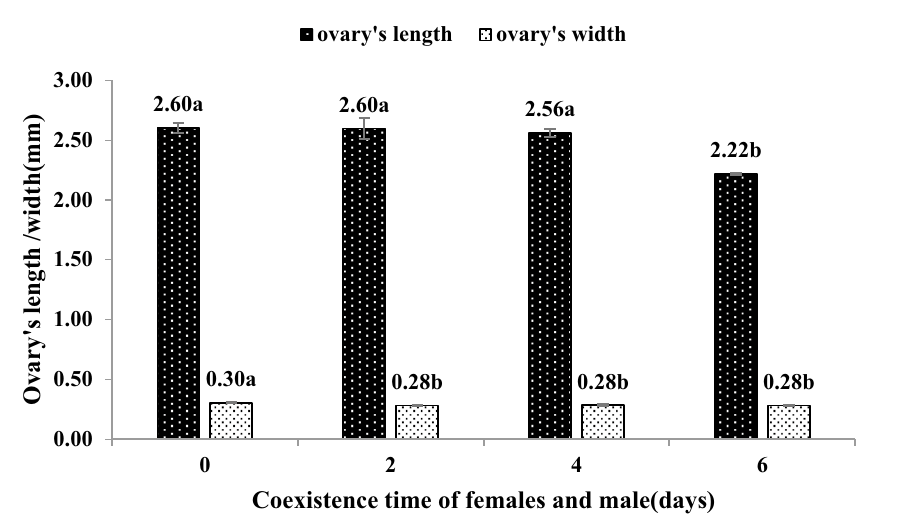
Figure 4. The length and width of C. japonicus ovary at different coexisting time of female and male adults. Data in the figure is mean ± standard error, different letters indicate significant differences in Duncan’s test, with a probability of